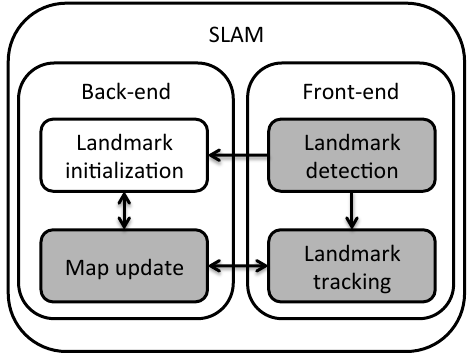
Figure 1. General block diagram of the SLAM solution. The blocks in gray represent the contributions of the present